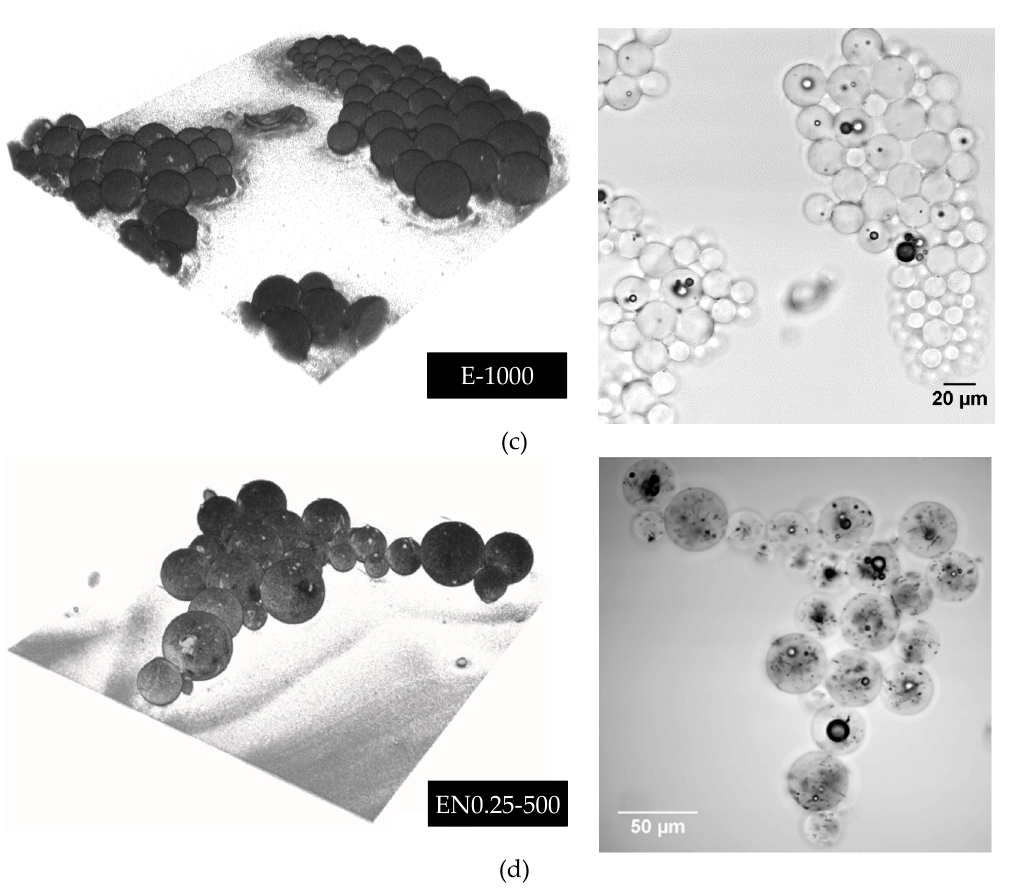
Figure 2. Representative images illustrating 3D reconstructions (left side) and mid-plane (right side) LSCM images of different microcapsules prepared at: ( a ) 300 rpm with 0.5 wt % CNTs, ( b ) 1000 rpm with 0.5 wt % CNTs, ( c ) 1000 rpm with no CNTs, and ( d ) 500 rpm with 0.25 wt % CNTs. Each 3D image is reconstructed from a stack of LSCM optical sections collected along the optical axis with a pixel size of 240 nm × 240 nm × 240 nm.